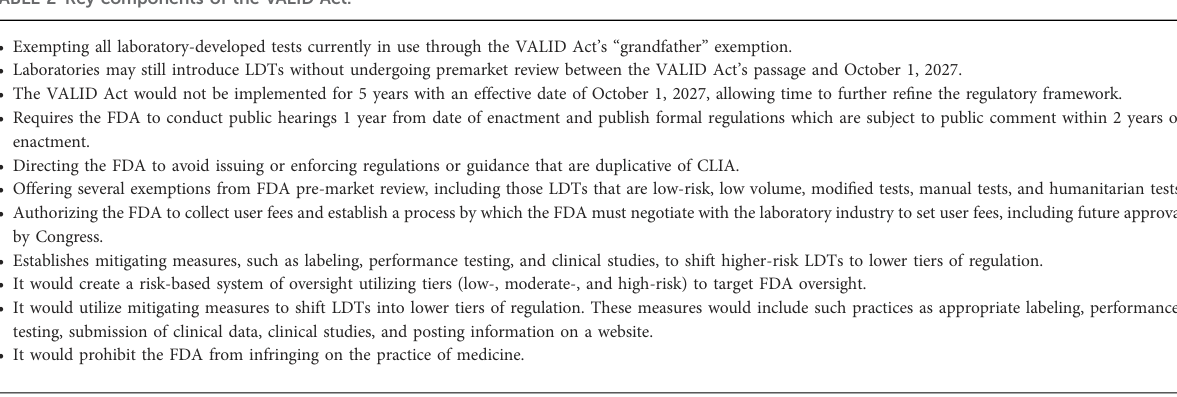
TABLE 2 Key components of the VALID